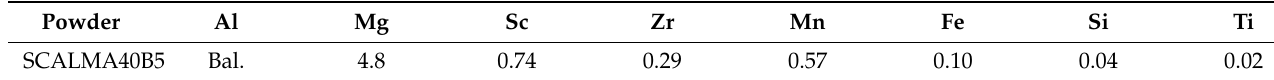
Table 1. Chemical composition of scalmalloy in weight percent.